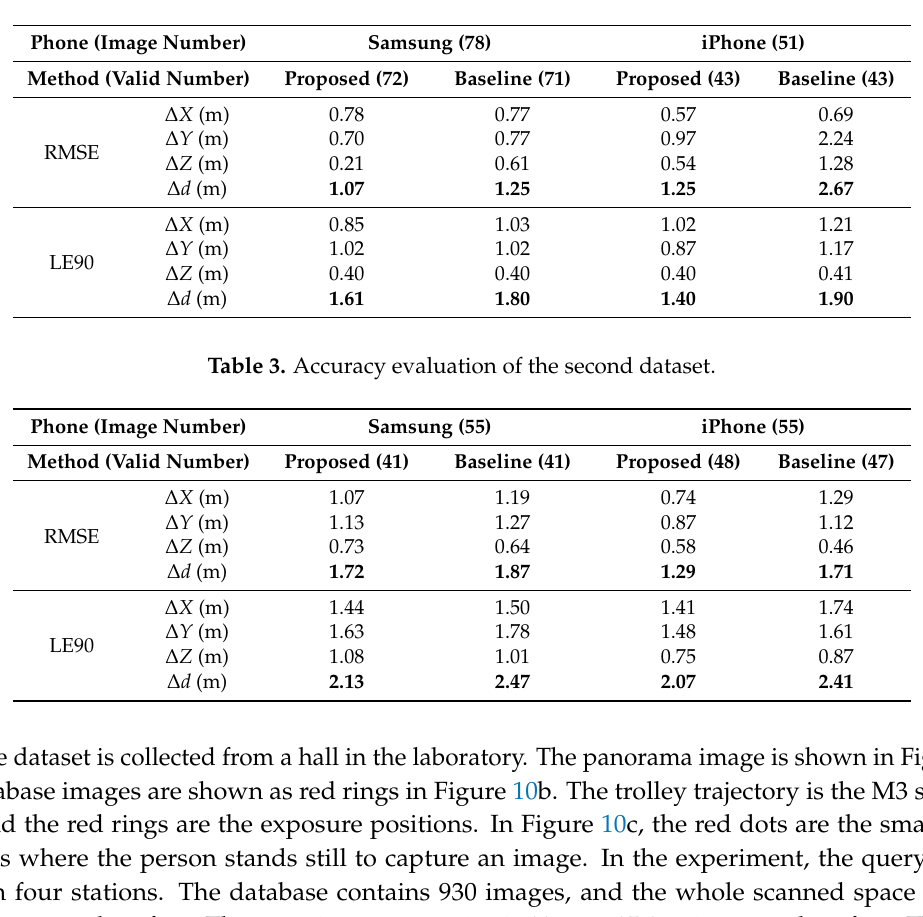
Table 2. Accuracy assessment of the first dataset.